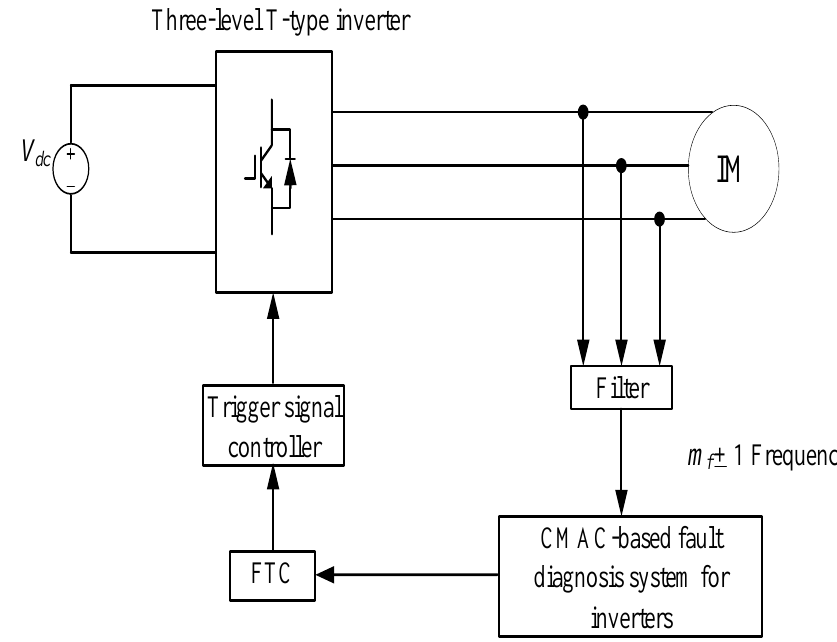
Figure 1. The CMAC-based fault diagnosis system for inverter architecture.